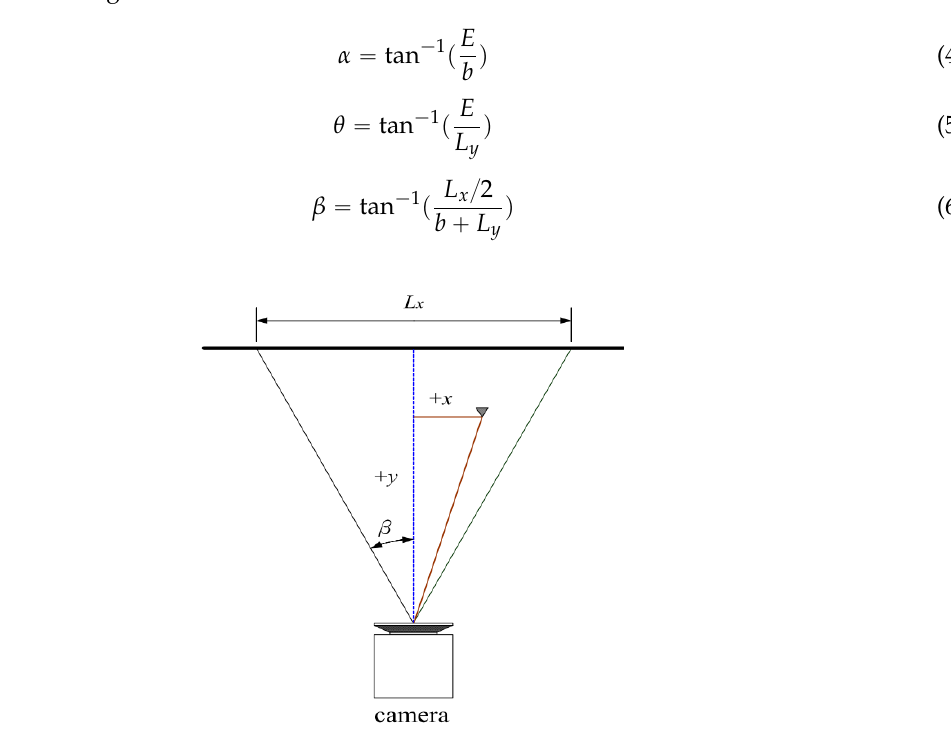
Figure 3. Side view of camera [17]. In Equations (7) and (8), u and v are the horizontal pixel and the vertical pixel of the center coordinates of the captured target, respectively. The H and W represent the pixel lengths of an image provided by the camera. In this paper, E is 15 cm, Lx is 160 cm, Ly is 150 cm, b is 10 cm, H is 320, and W is 480. We can obtain the center coordinates of the target after the image processing. The distance estimation is then used to calculate the distance between the WMR and the target. The dynamic tracking task can be performed via this information and the position of the target on an image frame. Figure 4 shows the relative coordinate of the target with respect to the WMR. y Figure 4. Relative coordinate of target with respect to wheeled mobile robot (WMR). 3. Fuzzy Control